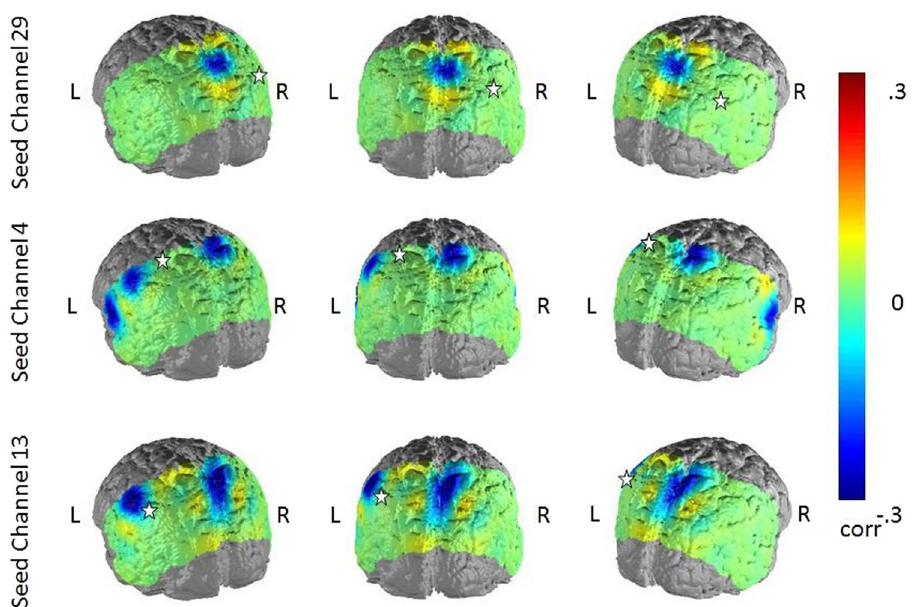
Figure 4. Correlations between state rumination and FC in the three seed regions of the depression-related network. Seed regions are marked by a white